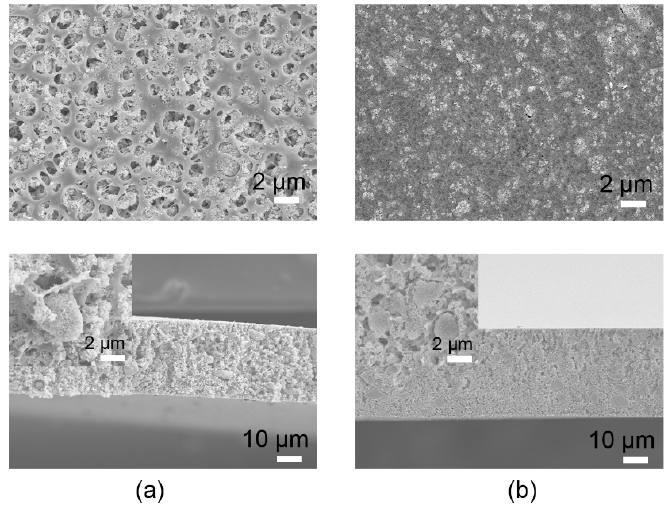
Figure 5. Nanosized ZIF-8 / PES composite materials prepared using ( a ) DMA and ( b ) NMP as the solvents. Top panels are images of the surface, and lower panels are cross-sectional images. Loading of ZIF-8 was 60 wt.%.